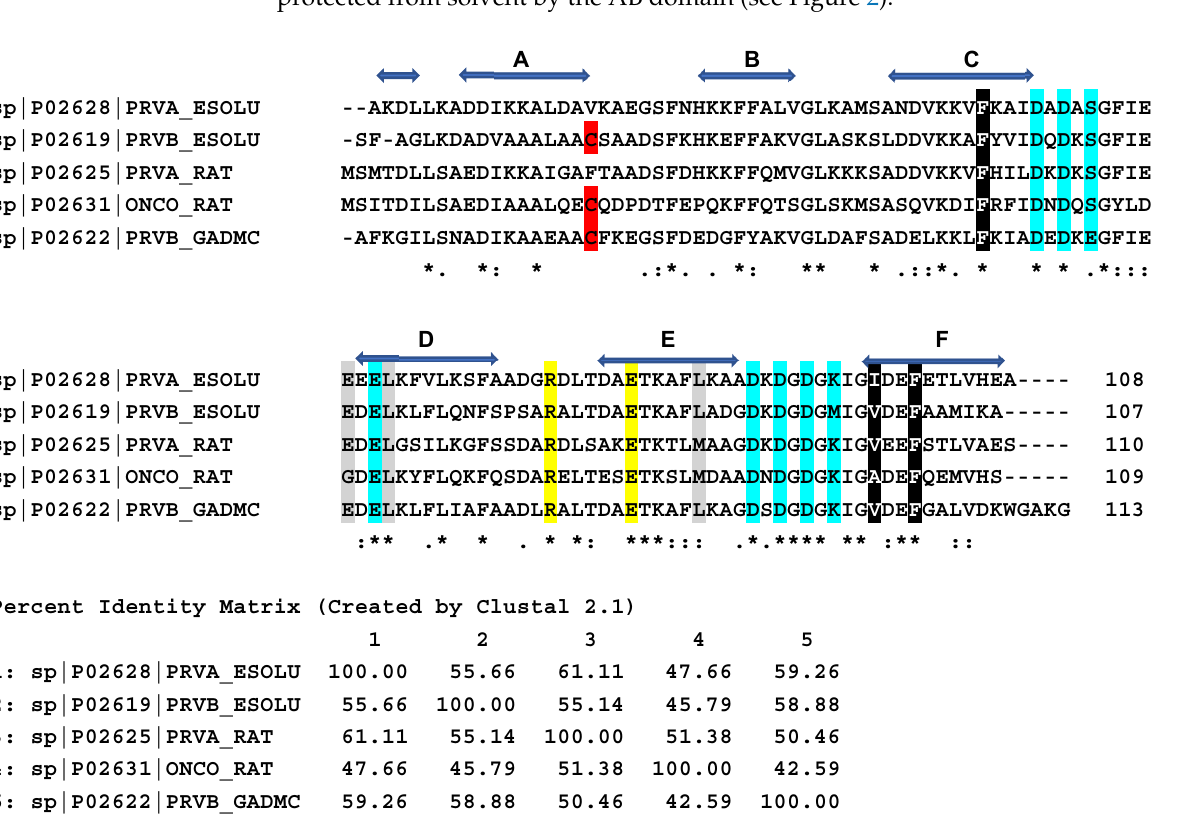
Figure 2. Amino acid sequences of pike α - and β -PAs, cod β -PA, and rat α - and β -PAs. Horizontal blue arrows show amino acids forming α -helices A through F in the native structure of pike α -PA. The consensus sequence characterizes identical residues as ‘ * ’, strongly similar residues as ‘ : ’, and weakly similar residues as ‘ . ’. Conservative Cys residue in β -PAs is shown in red. Amino acids taking part in calcium coordination are shown in cyan. Conservative Arg and Glu residues forming a salt bridge in the native structure of all PAs are shown in yellow. The data are taken from the UniProt database. Amino acids forming conservative clusters I and II are shown in black and gray, respectively. Percent identity matrix is also shown. Sequences were aligned by Clustal Omega (https://www.ebi.ac.uk/Tools/msa/clustalo/; accessed on 23 April, 2022).